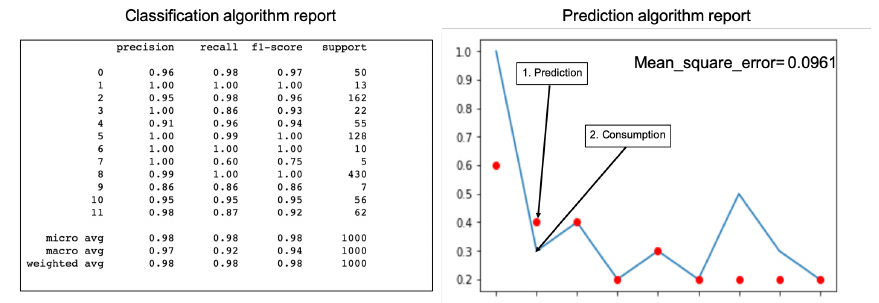
Figure 23. Classification and regression